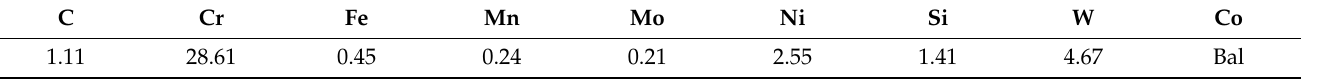
Figure 9. Schematic diagram of plasma cladding system.